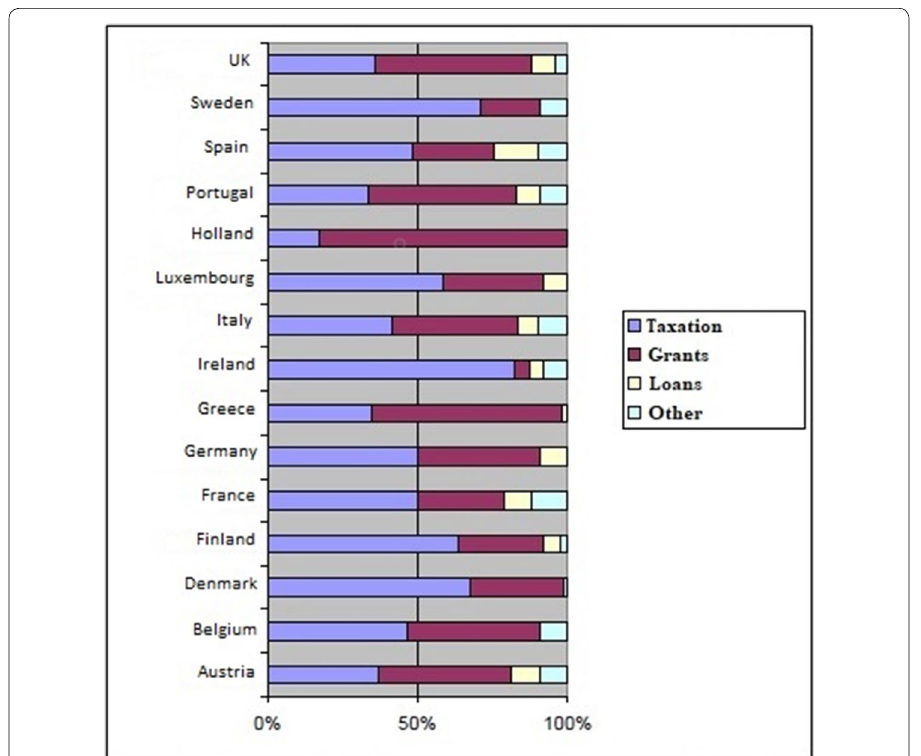
Fig. 3 Synthesis of local government revenue Source: European Commission